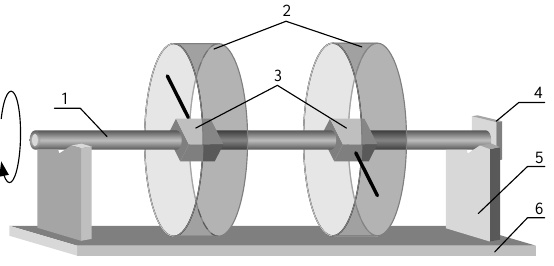
Figure 1. Instrument configuration. ( 1 ) Measuring rod; ( 2 ) coaxial hole part; ( 3 ) LDS; ( 4 ) baffle; ( 5 ) vee block; ( 6 )